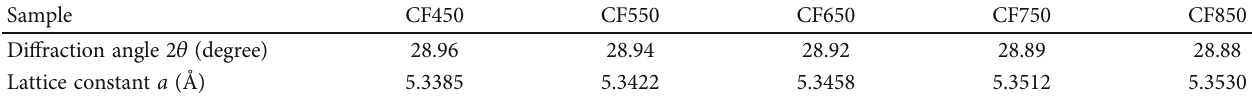
-Fe O mixed oxides calcined at di ff erent temperatures for 2h. 2 2 3